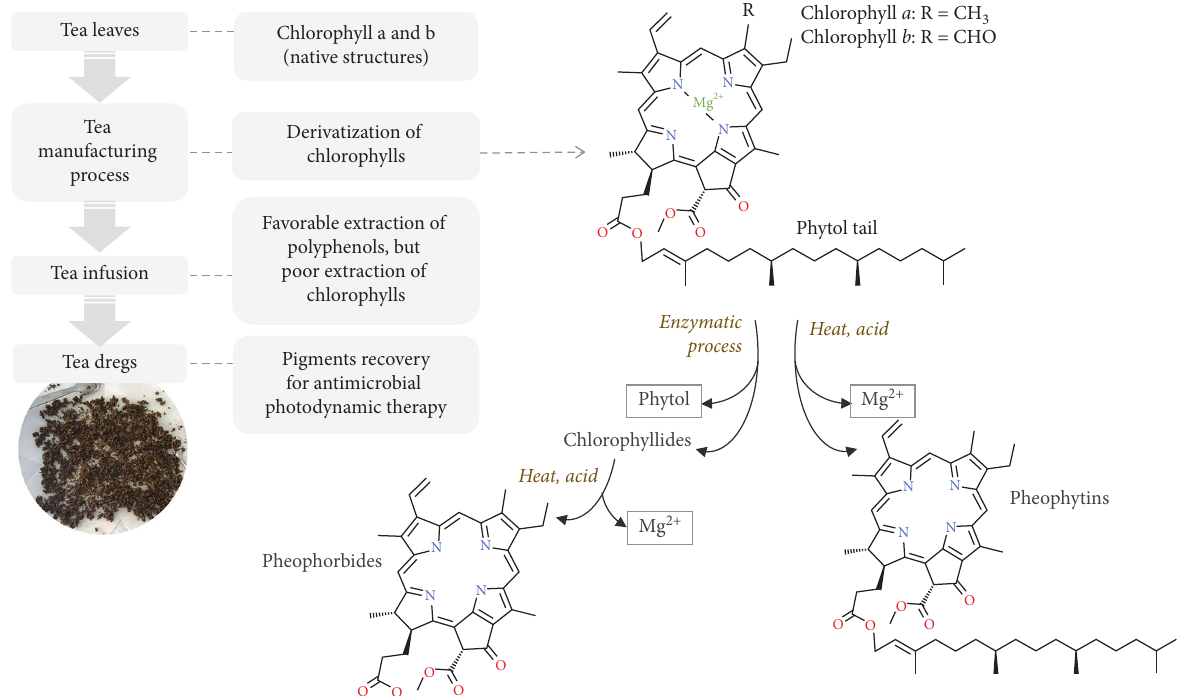
Figure 1: Schematic diagram of the research background. The manufacturing process of tea leads to derivatization of naturally occurring chlorophylls in the tea leaves. The derivatives (pheophytins and pheophorbides) are known as potential candidates of photosensitizers for antimicrobial photodynamic therapy. Since these pigments are poorly extracted in water, they could be recovered from the tea dregs for further